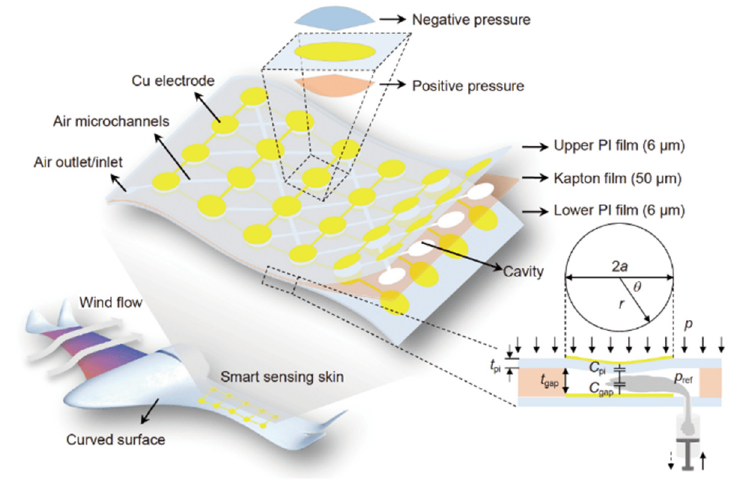
Figure 10. Conformable, programmable, and step-linear sensor array for large-range wind pressure measurements on a curved surface. Reproduced with permission from Ref. [122]. Copyright 2020, Science China Press and Springer-Verlag GmbH Germany, part of Springer Nature.